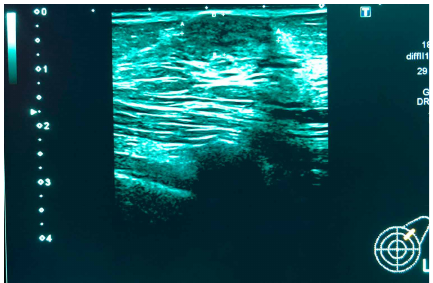
Figure 5: Ultrasound of the left breast showing a well-defined hypoechoic solid mass lesion, measuring 16 mm × 7